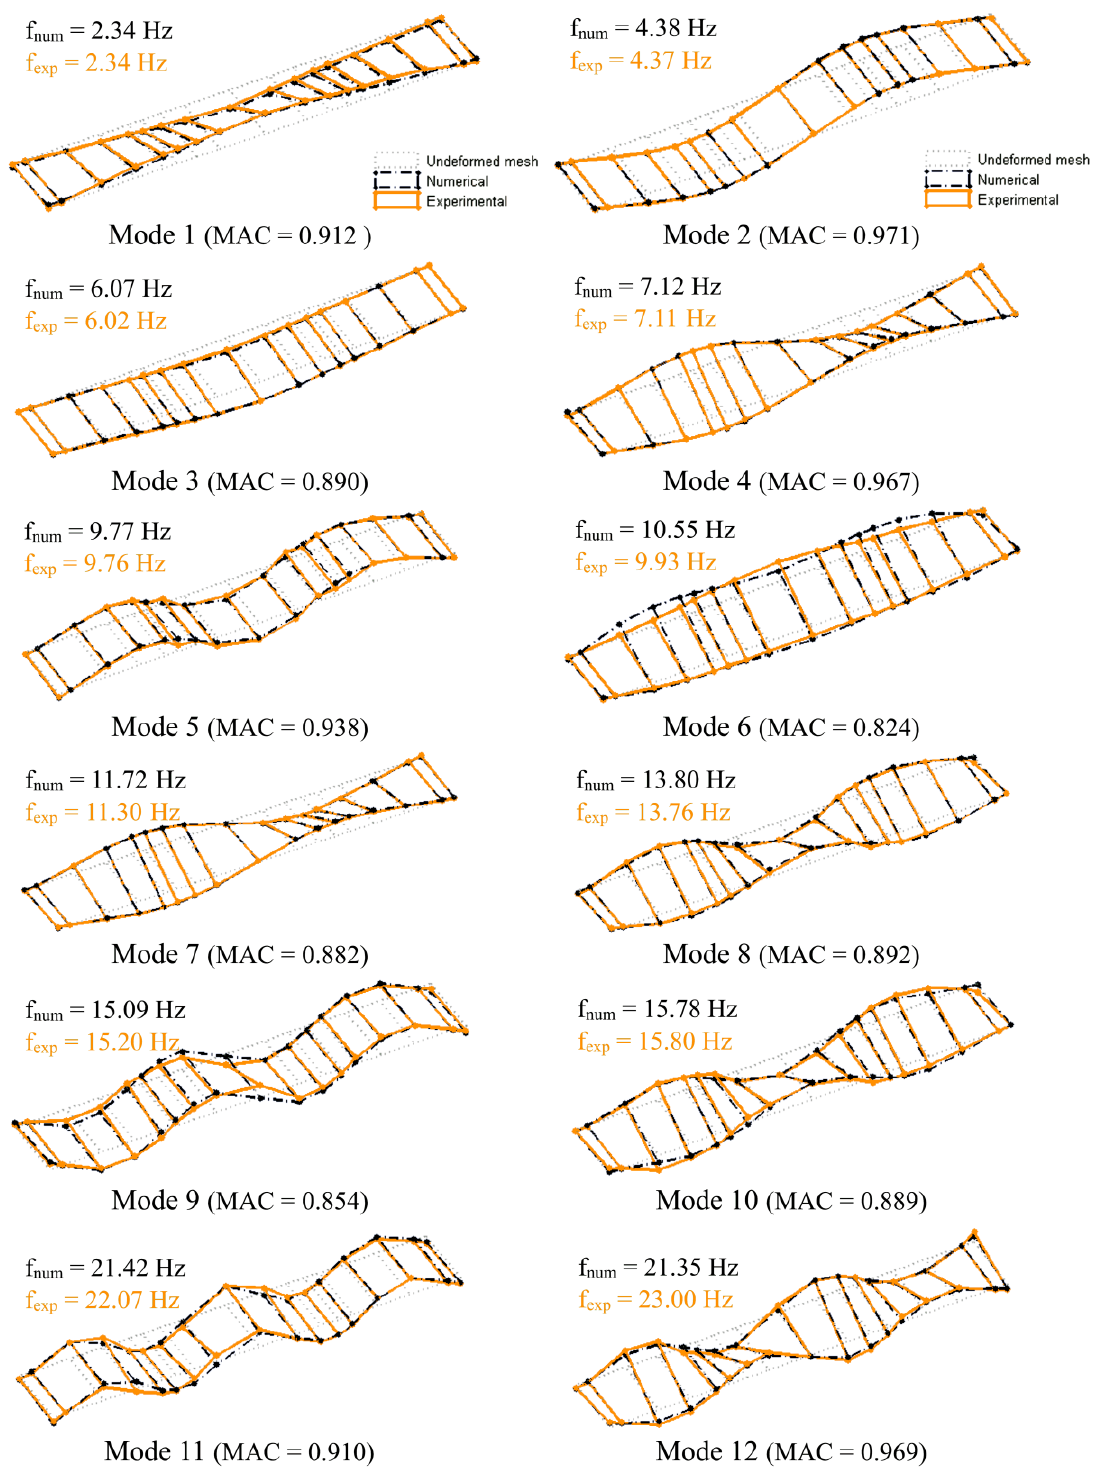
Figure 3. Comparison of the global vibration modes of the bridge obtained experimentally and numerically.